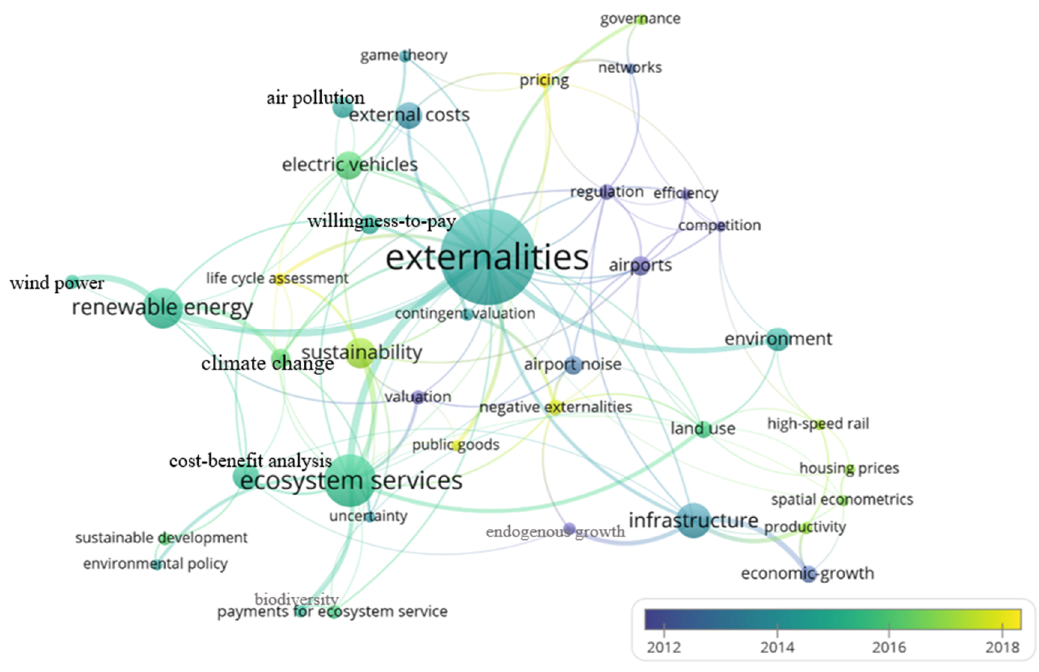
Figure 6. Visualization of author keywords evolution from 1978 to